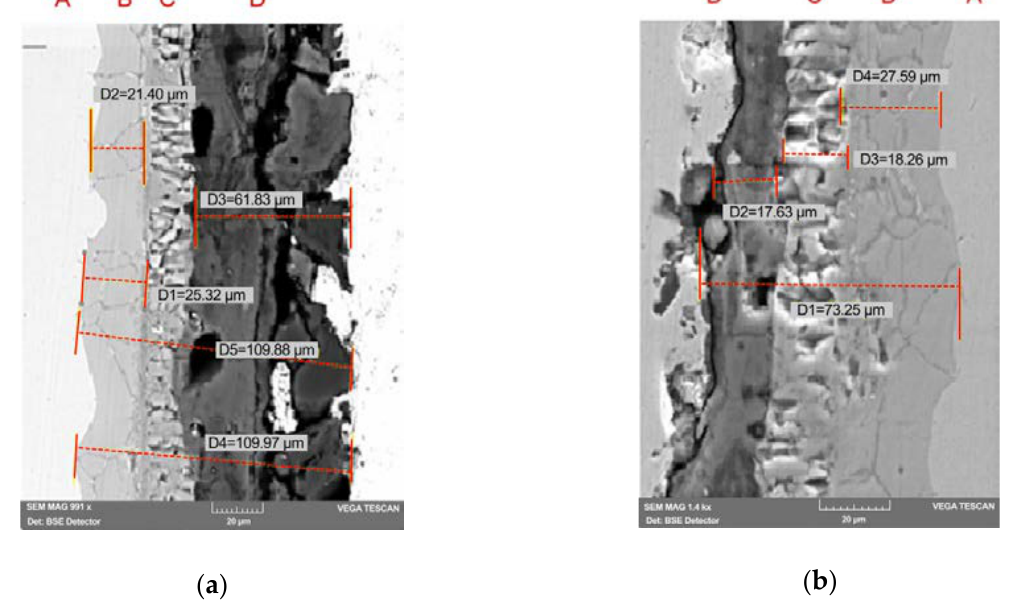
Figure 6. Cross-sectional SEM images for: ( a ) S1 sample; ( b ) S2 sample.